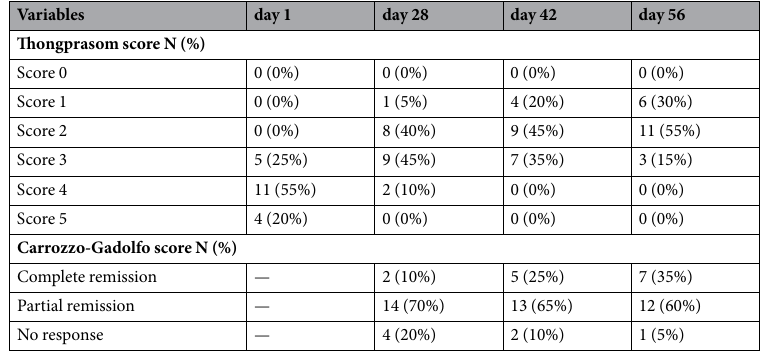
Table 2. Evaluation of treatment response according to Thongprasom, and Carrozzo and Gandolfo scores 50,51 .